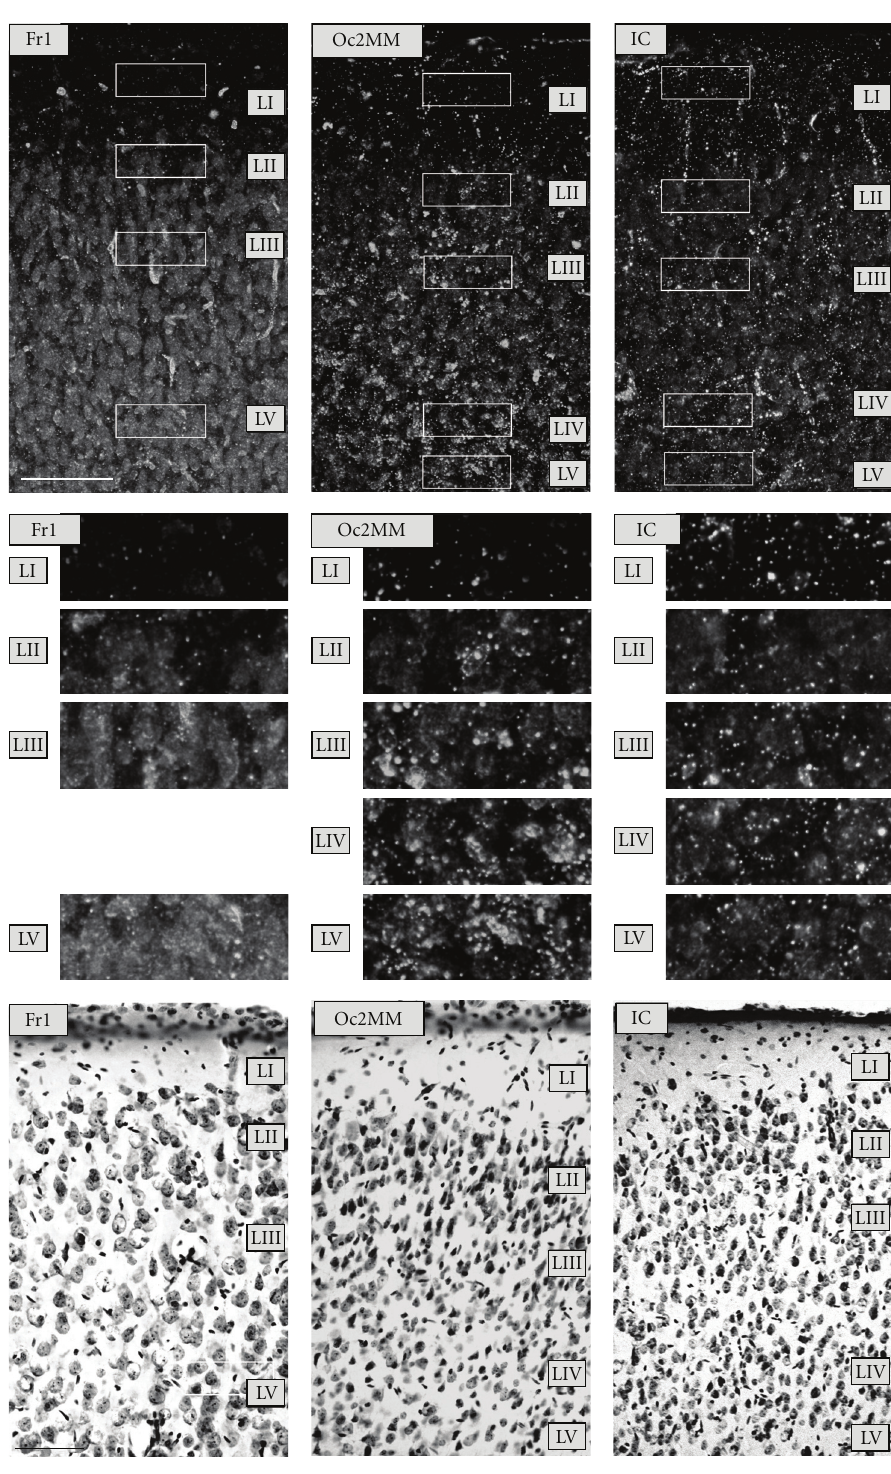
Figure 2: Top panel. Degrading axon terminals as indicated by silver-stained granules (light intensities) after Gallyas et al. (1980) [32] throughout the cortical layers of motor (Fr1), secondary sensory (Oc2), and limbic areas (IC) of an enriched-reared gerbil (dark field at 200x magnification). Middle panel. For every picture of the Gallyas staining, the marked sections (one per layer) were amplified. Note the distinct distribution of silver-stained granules in the di ff erent layers and areas. Bottom panel. Congruent sections (Nissl stainings) of the respective cortical areas. Scale bar = 100 µ